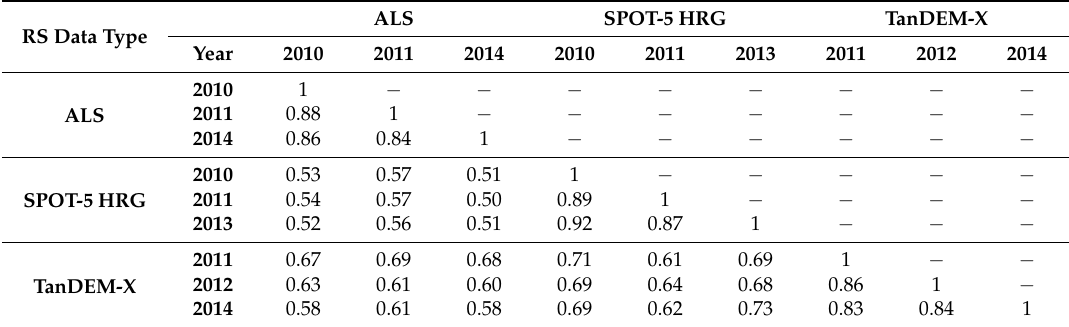
Table C1. Residual correlations between and within three different RS data types in estimating mean diameter.